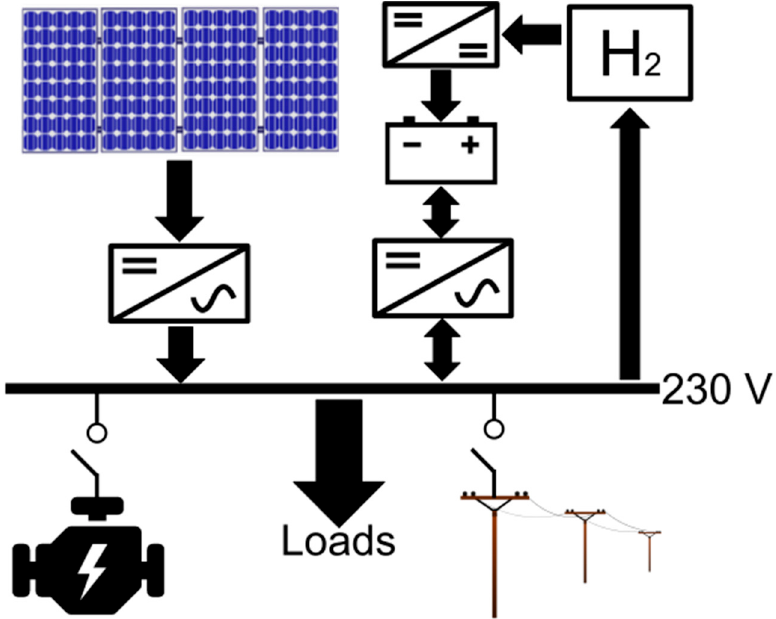
Figure 1. Simplified schematic of the energy system for the nanogrid. Reproduced with permission from [7], Nömm, J.; Rönnberg, S.K.; Bollen, M.H.J. An Analysis of Frequency Variations and its Implications on Connected Equipment for a Nanogrid during Islanded Operation. Energies 2018, 11, 2456.